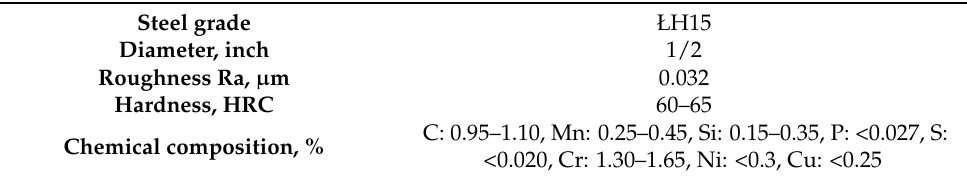
Figure 3. Four-ball tribosystem [53]; 1, ball pot; 2, ball chuck; 3, lower balls; 4, top ball. The test elements were standardized bearing balls with a nominal 1/2” diameter made test balls are provided in Table 1. Table 1. Test ball parameters.